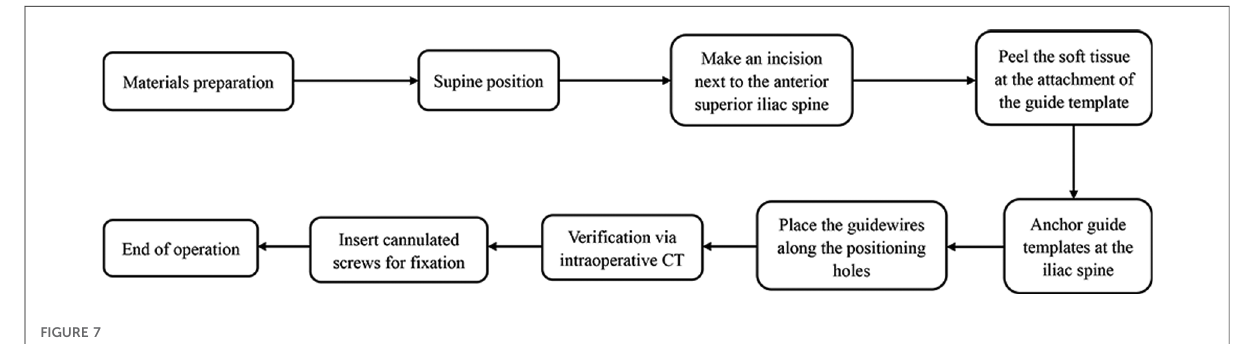
FIGURE 7 The operation work fl